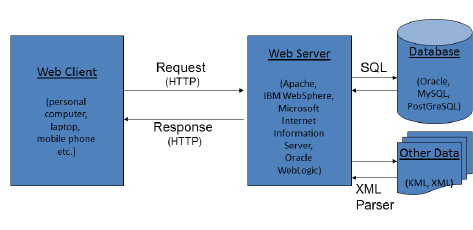
Figure 1: Mobile 3D Mapping